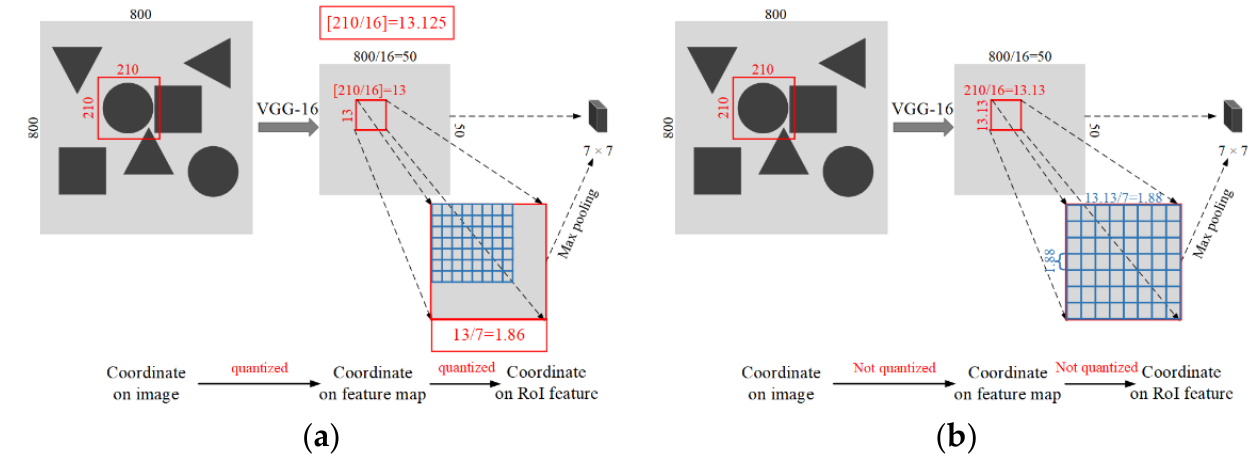
Figure 2. Schematic diagram of the RoIPooling and RoIAlign. ( a ) RoIPooling; ( b ) RoIAlign.